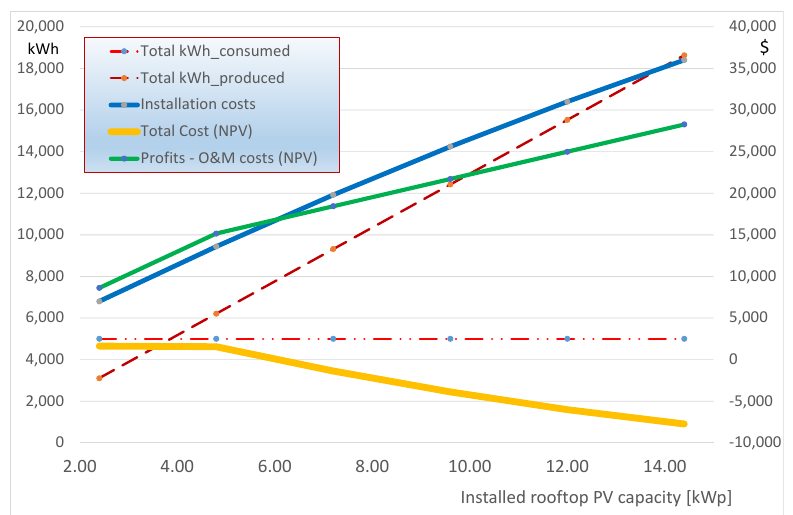
Figure 10. Lifetime performance (20 years) of the system with variable capacity of rooftop PV panels. Electricity price USD 0.10 per kWh, plus USD 0.10 premium for the part self-consumed. Tilt angle is set to the optimal value of 30